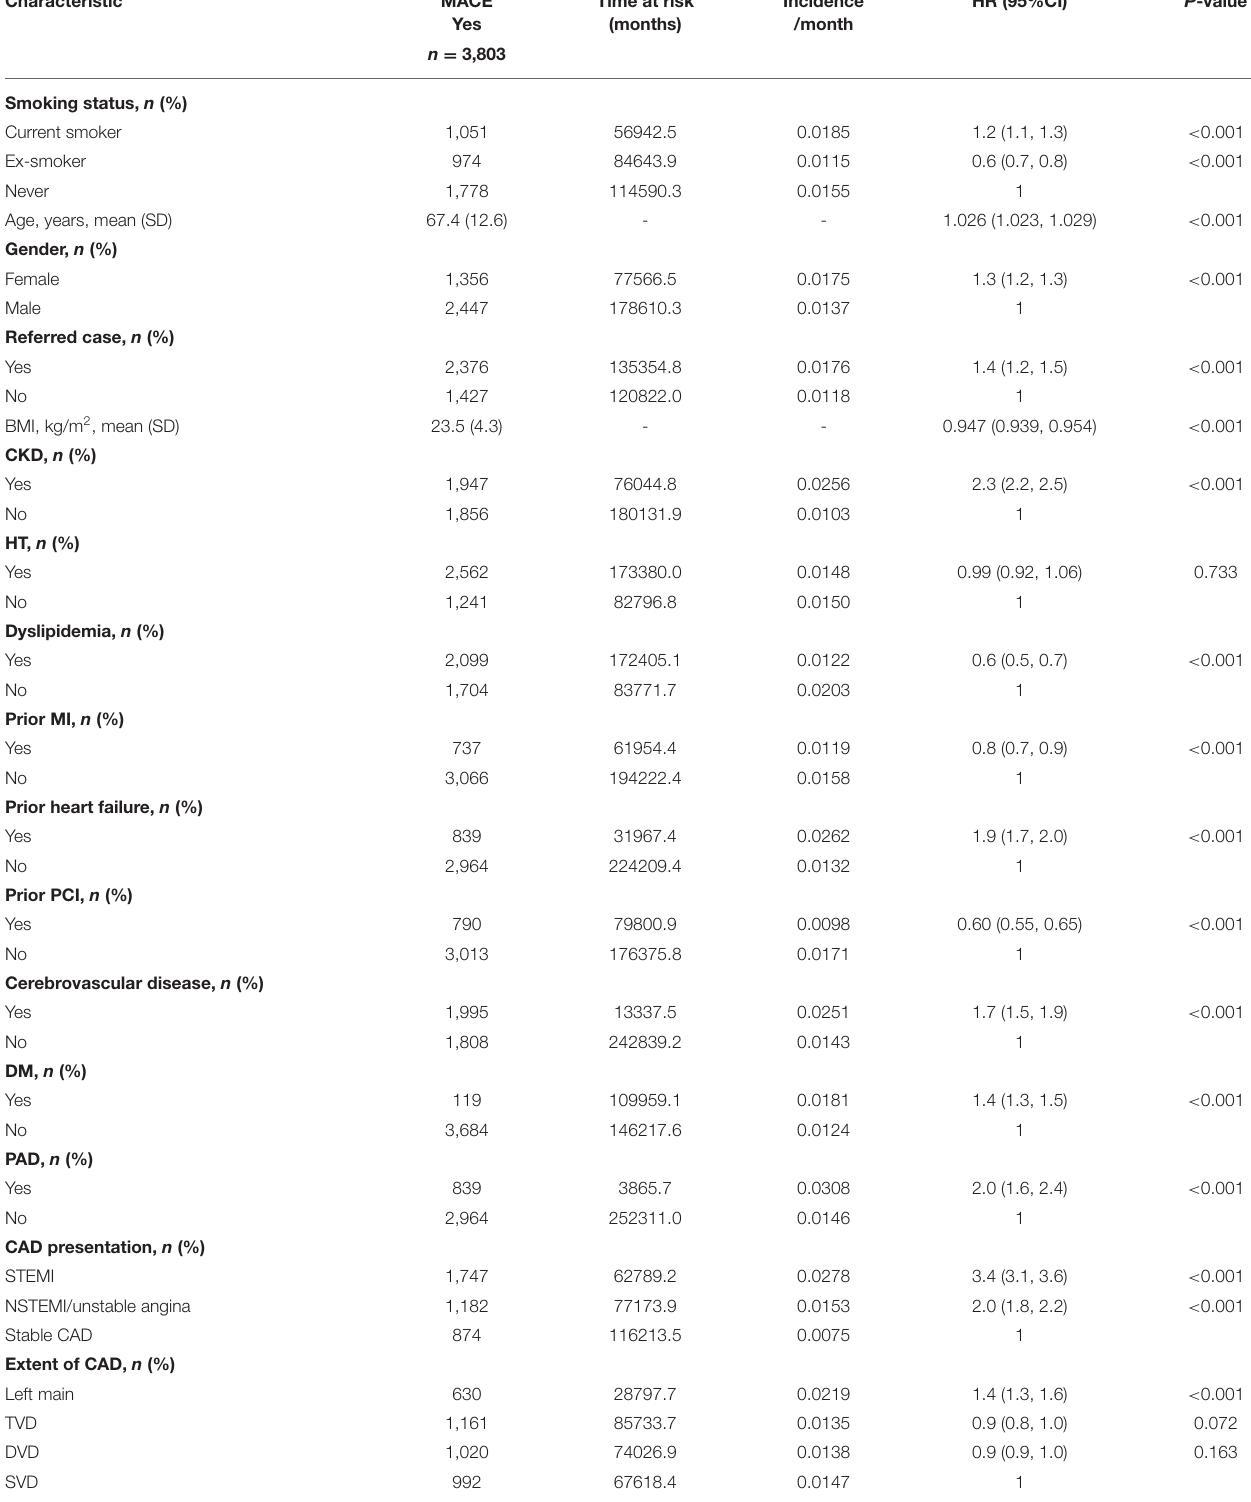
TABLE 2 | Estimation of MACE development to smoking and other risk factors: A univariate analysis. Characteristic MACE